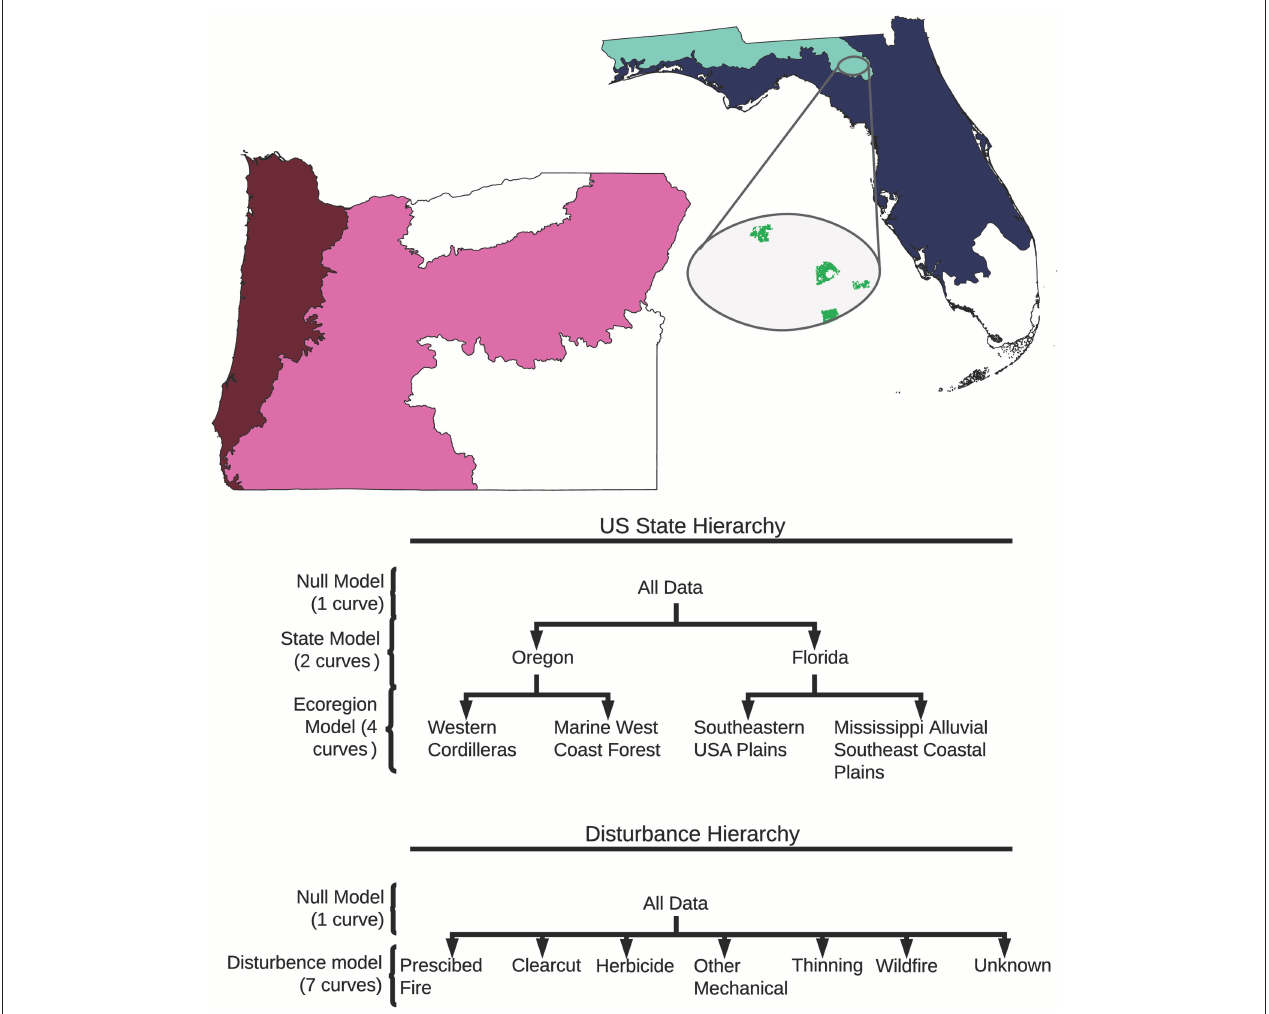
FIGURE 7 | Visualization of data subsetting and model hierarchies. Colored regions show what portions of Oregon and Florida were used in analyses. Cutouts show a sample of LANDFIRE raster file with disturbances in green. Model hierarchies show the different models compared, and the data used to make each curve.